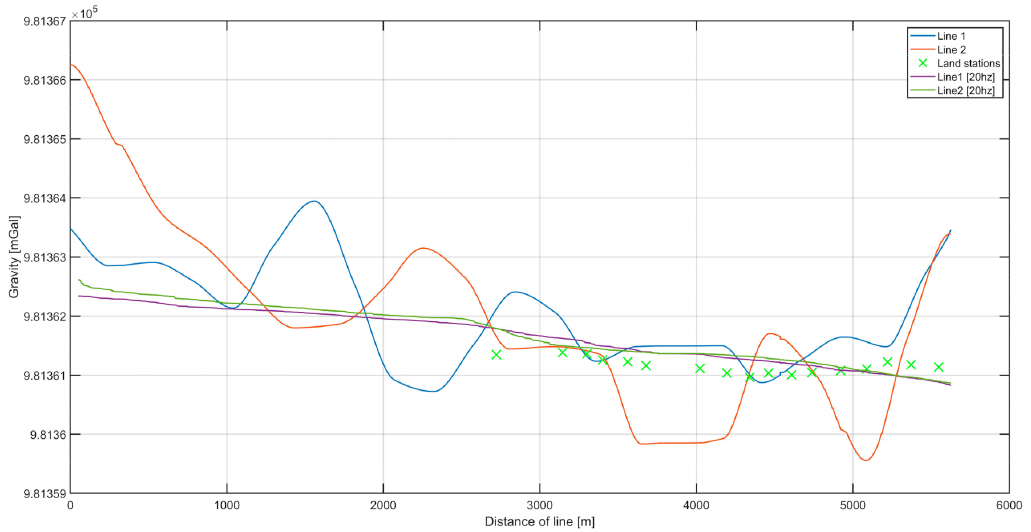
Figure 14. The comparison of results from all campaigns performed on the Odra river.